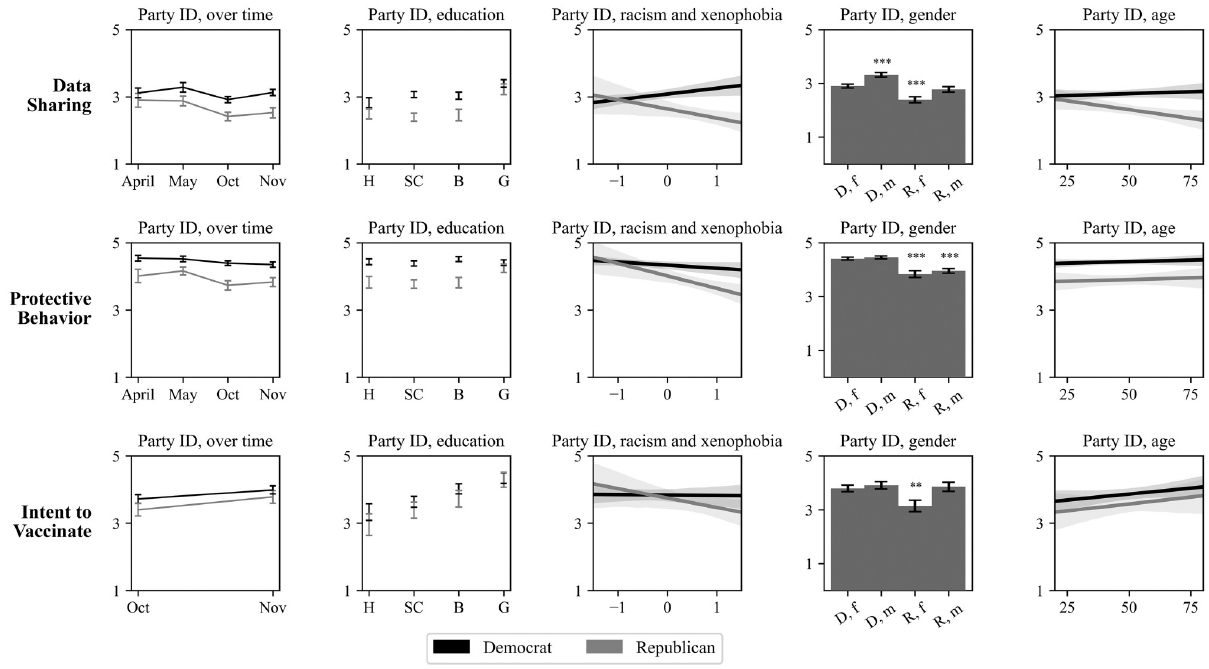
Fig 2. Association between independent variables and data sharing, health behavior, and vaccination by party ID. Figure shows relationship between month (column 1), education (column 2), racism and xenophobia (column 3), gender (column 4), and age (column 5) on the x axes and data sharing (first row), protective behavior (second row), and intent to vaccinate (third row) on the y axes. Estimates for Democrats (in black) and Republicans (in gray). Error shows standard error of the mean, and shaded area around the line of best fit represents the 95% confidence interval. The time scales in the first column correspond to the months we collected responses, and are not evenly distributed. The specific dates are: 4/3–4/8, 5/1–5/ 11, 10/19–10/28, 11/20–11/25. All data collected in 2020. Codes for the x-axis are as follows: H = high school diploma, SC = some college or associate’s degree, B = bachelor’s degree, G = graduate degree. D,f = Democrat and female, D,m = Democrat and male, R,f = Republican and female, R, m = Republican and male. ⟊ = p < 0 . 10 , � = p < 0 . 05 , �� = p < 0 . 01 , ��� = p < 0 . 001 . P-value measured by two-tailed